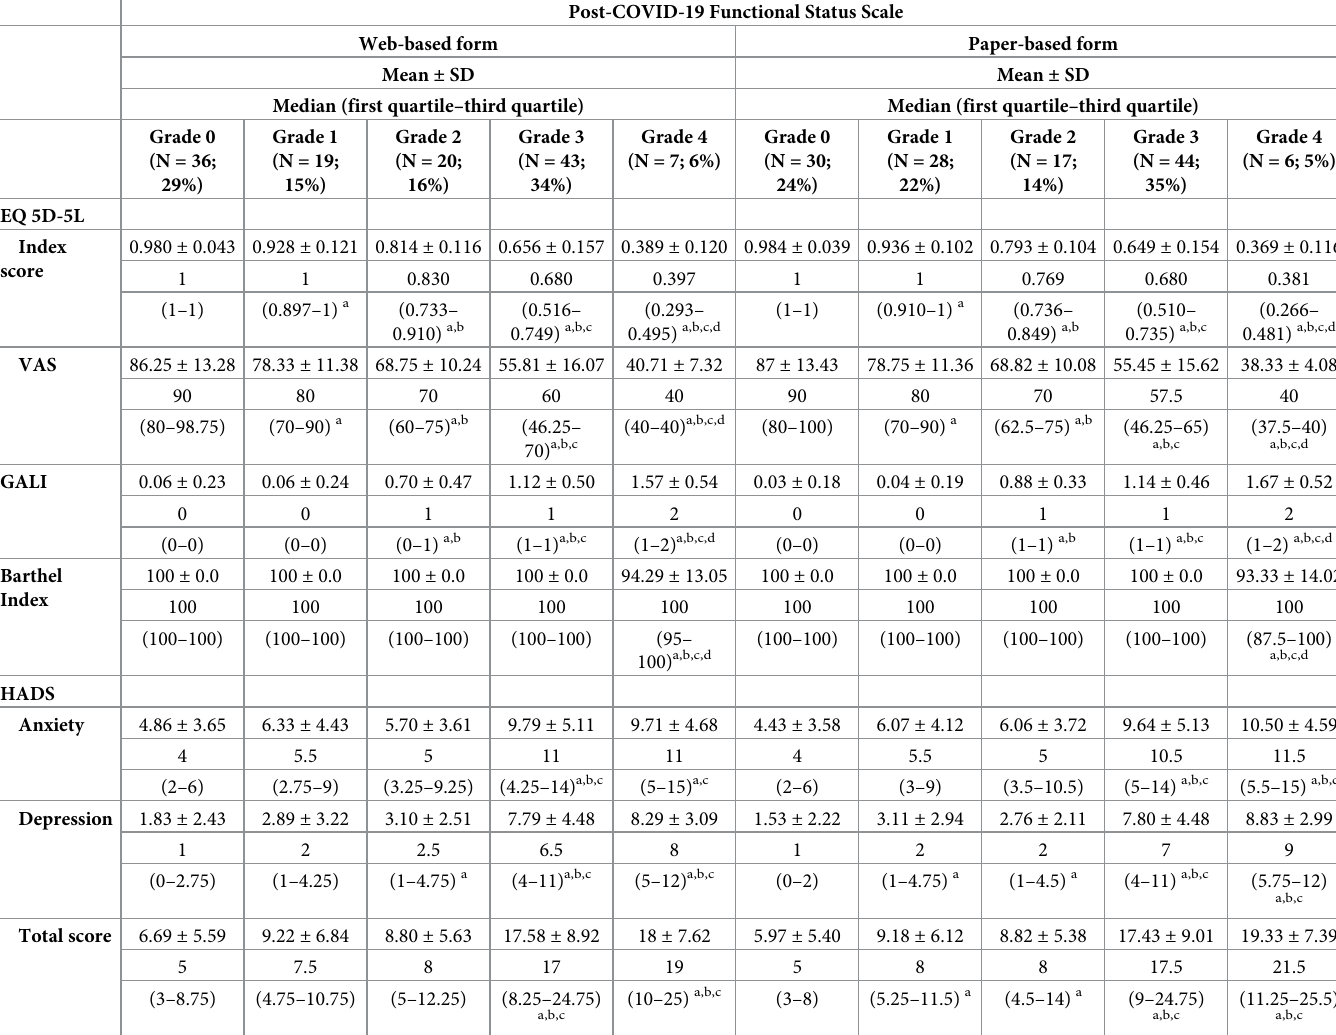
Table 3. Multiple comparisons between participants with different degrees of functional status impairment according to the PCFS scale for quality of life, limita- tions in activities of daily living and psychological status. Post-COVID-19 Functional Status